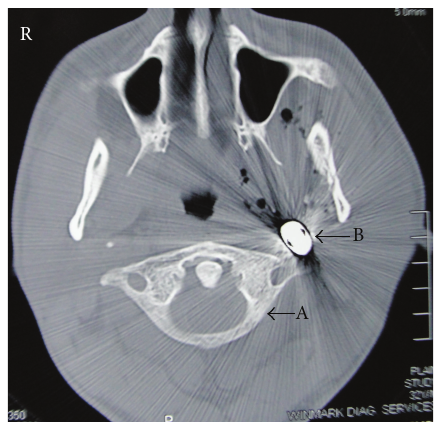
Figure 4: CT scan passing through the atlas, showing the bullet (B) in the left parapharyngeal space anterolateral to the transverse processoftheatlas(A)withairpocketsaroundit.Notethereflection of X-rays by the bullet.